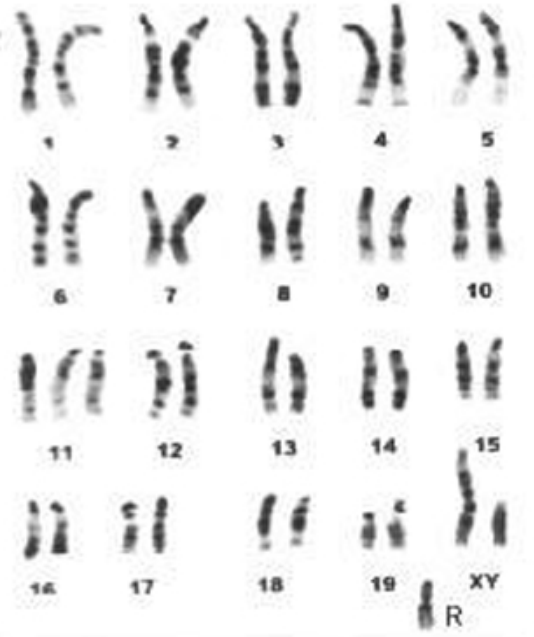
Figure 1 - GTG-banded karyotype of a HESS-2 cell with trisomy of chro- mosome 11 and a structural rearrangement (R) (Passage 38).